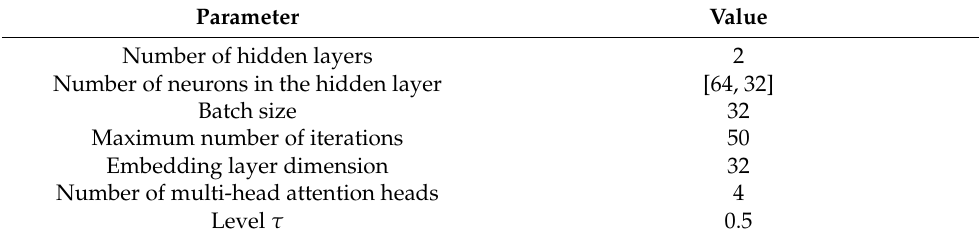
Table 1. The main parameters of the NNMs.